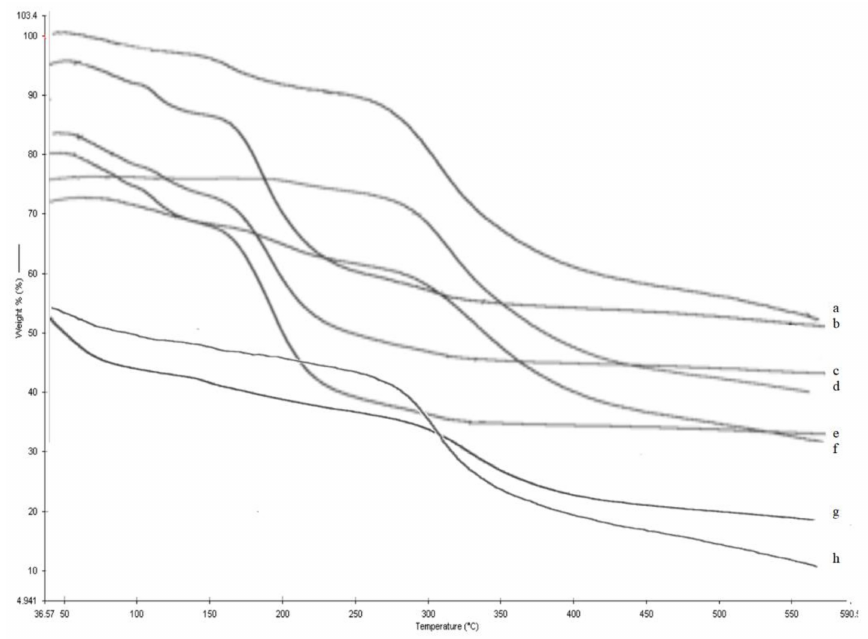
Figure 6. Thermograms of 0.1% β -arbutin (a), 0.2% β -arbutin (b), 0.3% β -arbutin (c), 0.4% β -arbutin